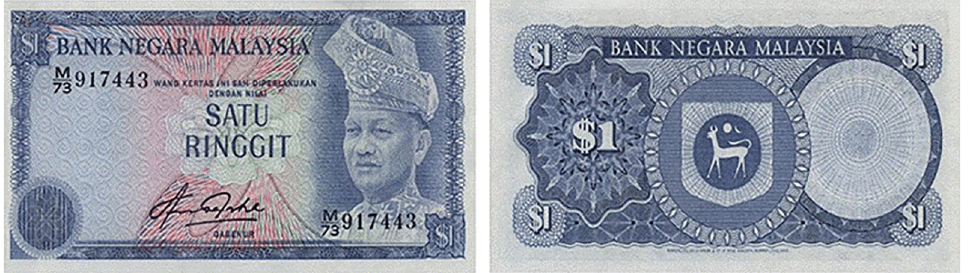
Figure 1. Malaysian $1.